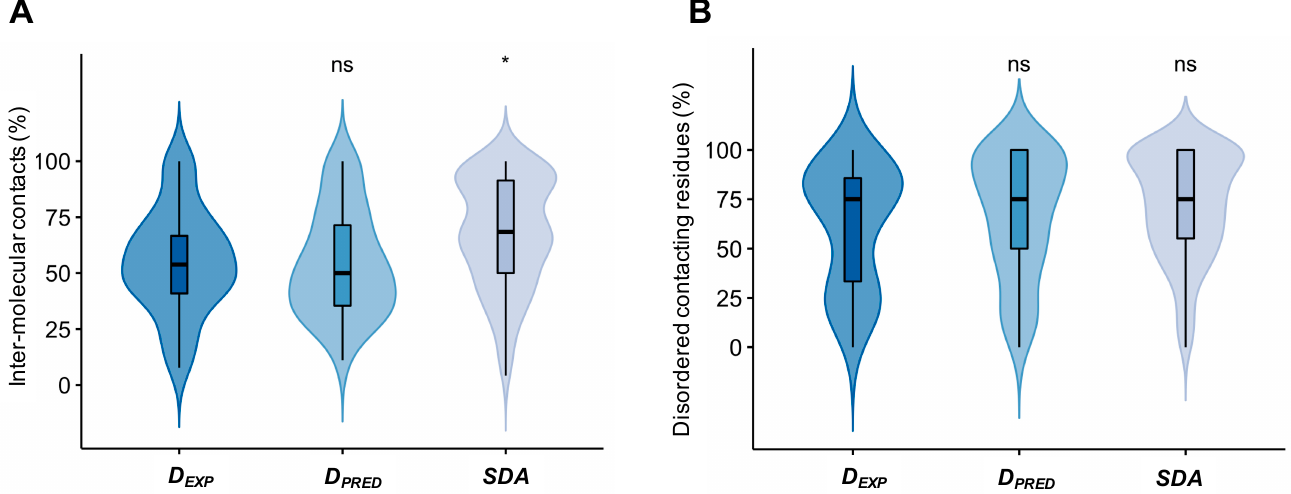
Figure 3. Residues involved in persistent contacts (f C ≥ 0.75; f C = N C /N TOTAL , where N C is the number of models when the residue is in contact, and N TOTAL is the number of all models) in specific complexes of experimental droplet-driving proteins (D EXP ), predicted droplet-driving proteins (D PRED ) and specific disordered assemblies (SDA). ( A ) The percentage of interface residues that are involved in partner contacts in at least three-quarters of the conformers of the ensemble. ( B ) The percentage of disordered residues in the pool of residues with persistent contacts (f C ≥ 0.75); based on the DSSP method. Statistical significances were computed by the Mann–Whitney test, using the R program (ns: p > 0.05, * p ≤ 0.05). Table 1. Structural variations in specific assemblies of experimentally identified (D EXP ) and predicted (D PRED ) droplet-forming proteins and specific disordered assemblies (SDA). Root-mean- square deviations (RMSD) are computed for residues establishing partner contacts in less than 0.25 of the models ( f C ≤ 0.25) and residues forming contacts in more than 0.75 of the models ( f C ≥ 0.75); f C = N C /N TOTAL , where N C is the number of models when the residue is in contact, and N TOTAL is the number of all models.